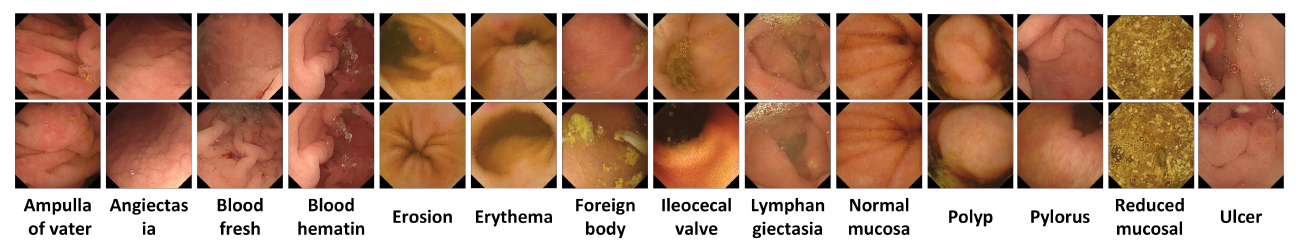
Figure 2. Original Kvasir-Capsule dataset samples extracted from WCE video frames with respect to each class label.